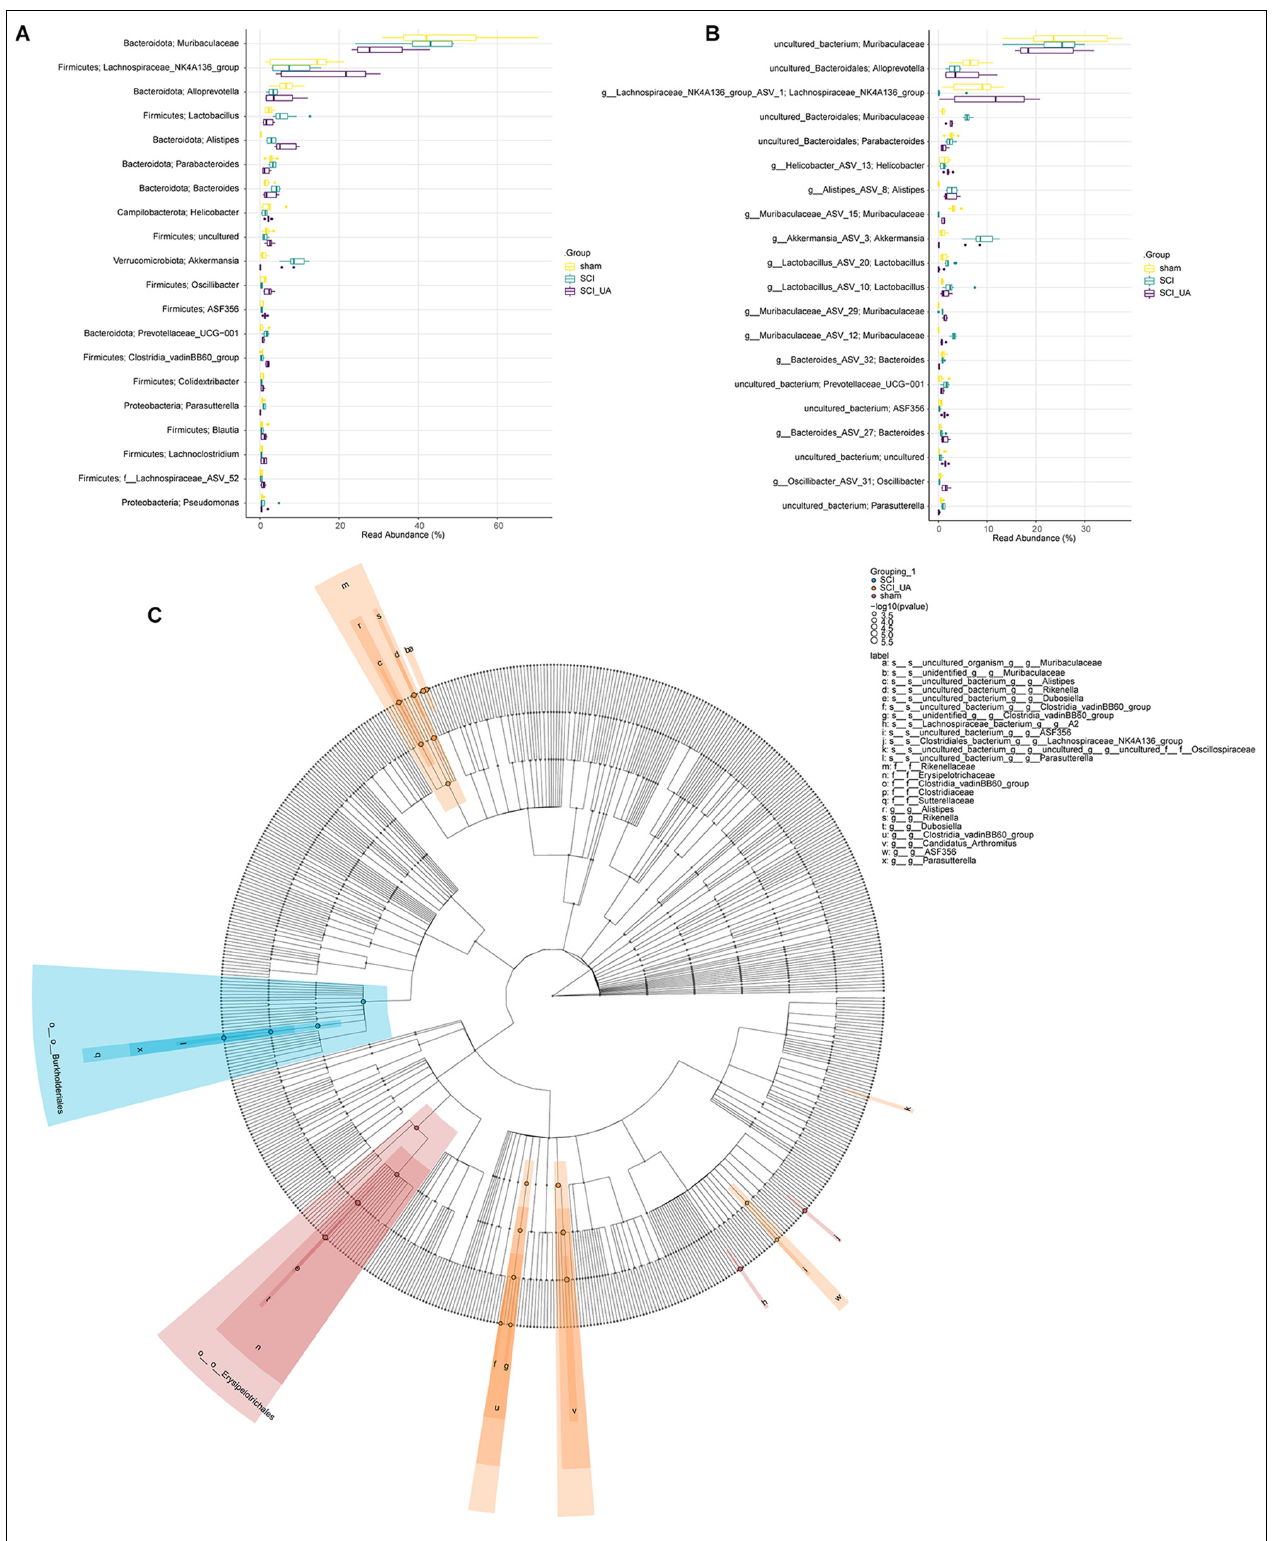
FIGURE 4 | UA improved the dominant gut microbiota of SCI mice. Boxplots were used to compare the 20 species with the highest relative abundance at (A) Phylum_Genus and (B) Species_Genus levels in each group. (C) LEfSE analysis was performed to seek the difference among groups.